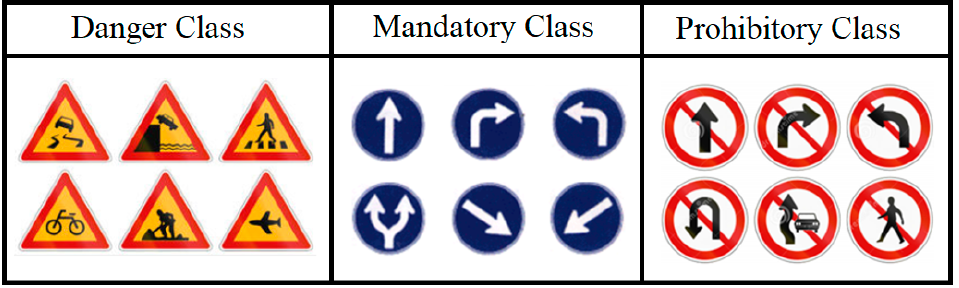
Figure 1. Three super classes of traffic signs used for experiment.